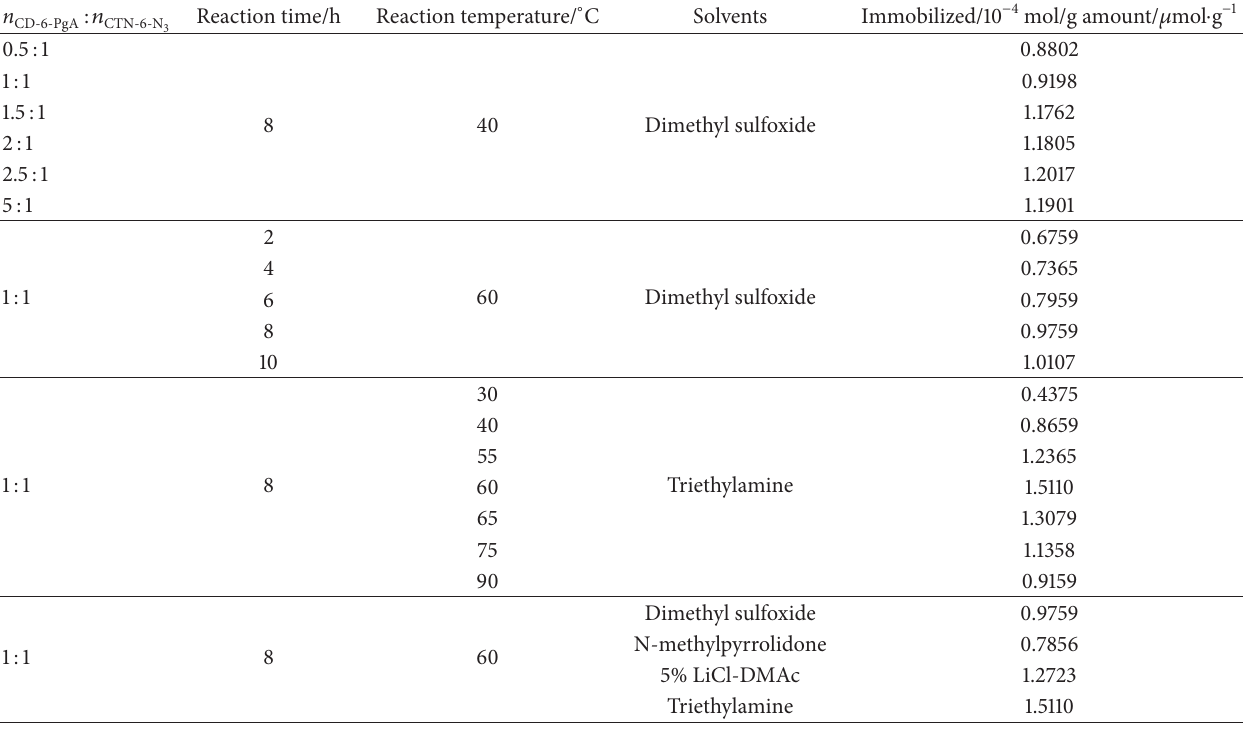
Table 1: The impact of the click reaction conditions on the immobilized amount of the 𝛽 -cyclodextrin in the product. n : 𝑛 CD-6-PgA CTN-6-N